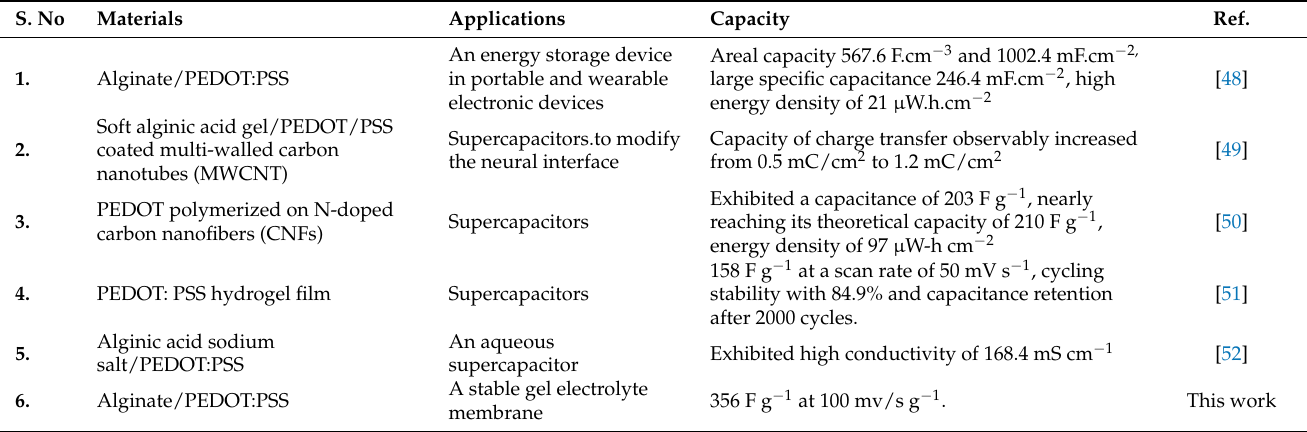
Figure 5. ( a ) CV curves of pure alginate hydrogel; ( b ) CV curves of pure alginate hydrogel with 2.5 mL PEDOT:PSS; and ( c ) CV curves of conductive alginate hydrogel with 5 mL PEDOT:PSS. Table 1. Comparison of the electrochemical performance of the assembled supercapacitor with the previous work.